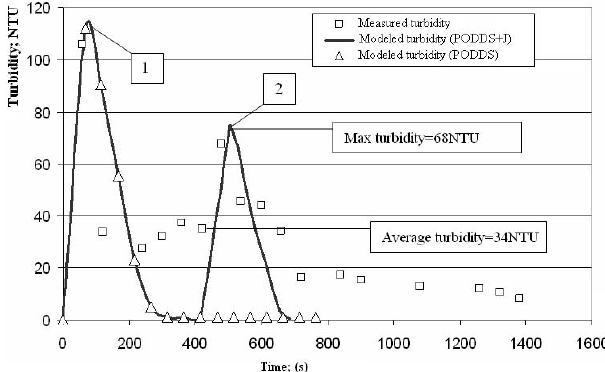
Figure 7. Turbidity curve for flushing site 1.